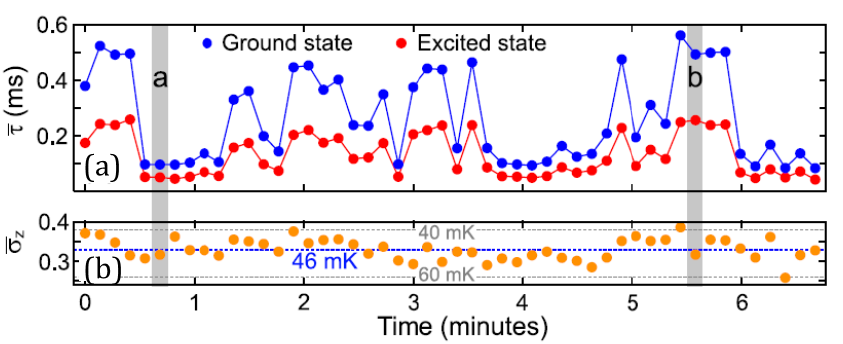
Figure 7: (adapted from Ref. [ 23 ] ). (a) Measurement of the average time spent by the qubit in the ground (blue) and excited (red) states vs time. There are significant fluctuations in these values over the course of minutes. (b) Polarization of the flux- onium qubit vs time. The dashed blue line marks the average polarization, which corresponds to a temperature of 46 mK, and the gray dashed lines are markers for 40 and 60 mK. Note that the qubit temperature is not correlated with the fluctua- tions between the quiet and noisy intervals. The qubit polarization σ analogy to a spin-1 / 2